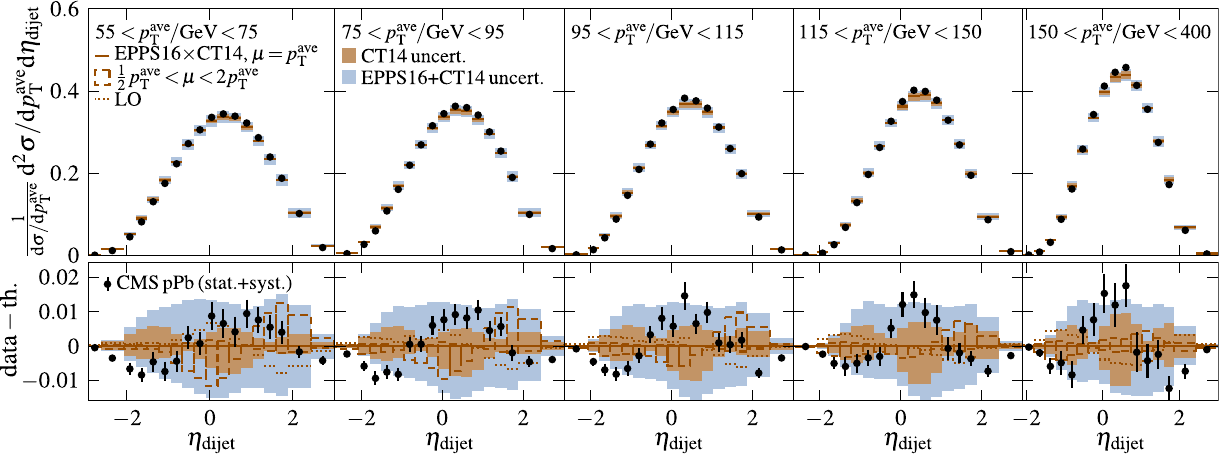
Fig. 7 As Fig. 2, but now with pPb data and predictions with EPPS16 nuclear modifications imposed on the CT14 NLO proton PDFs and omitting the results with μ = M dijet for clarity. Light blue boxes show the combined uncertainty from the CT14 and EPPS16 PDFs